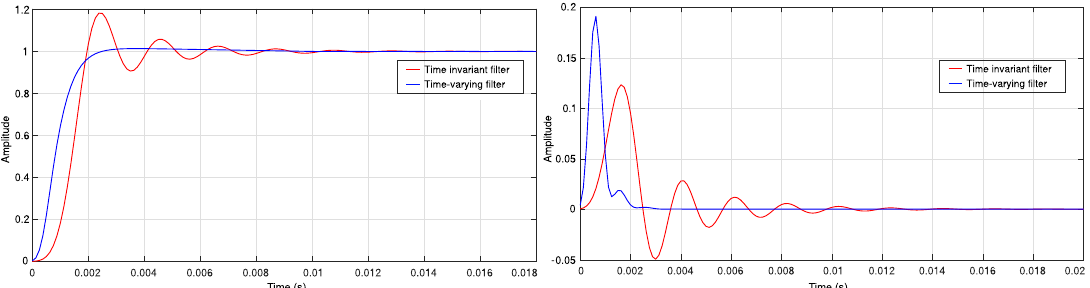
Figure 7. Step and impulse response of time invariant and discrete time-varying filter 500 Hz.